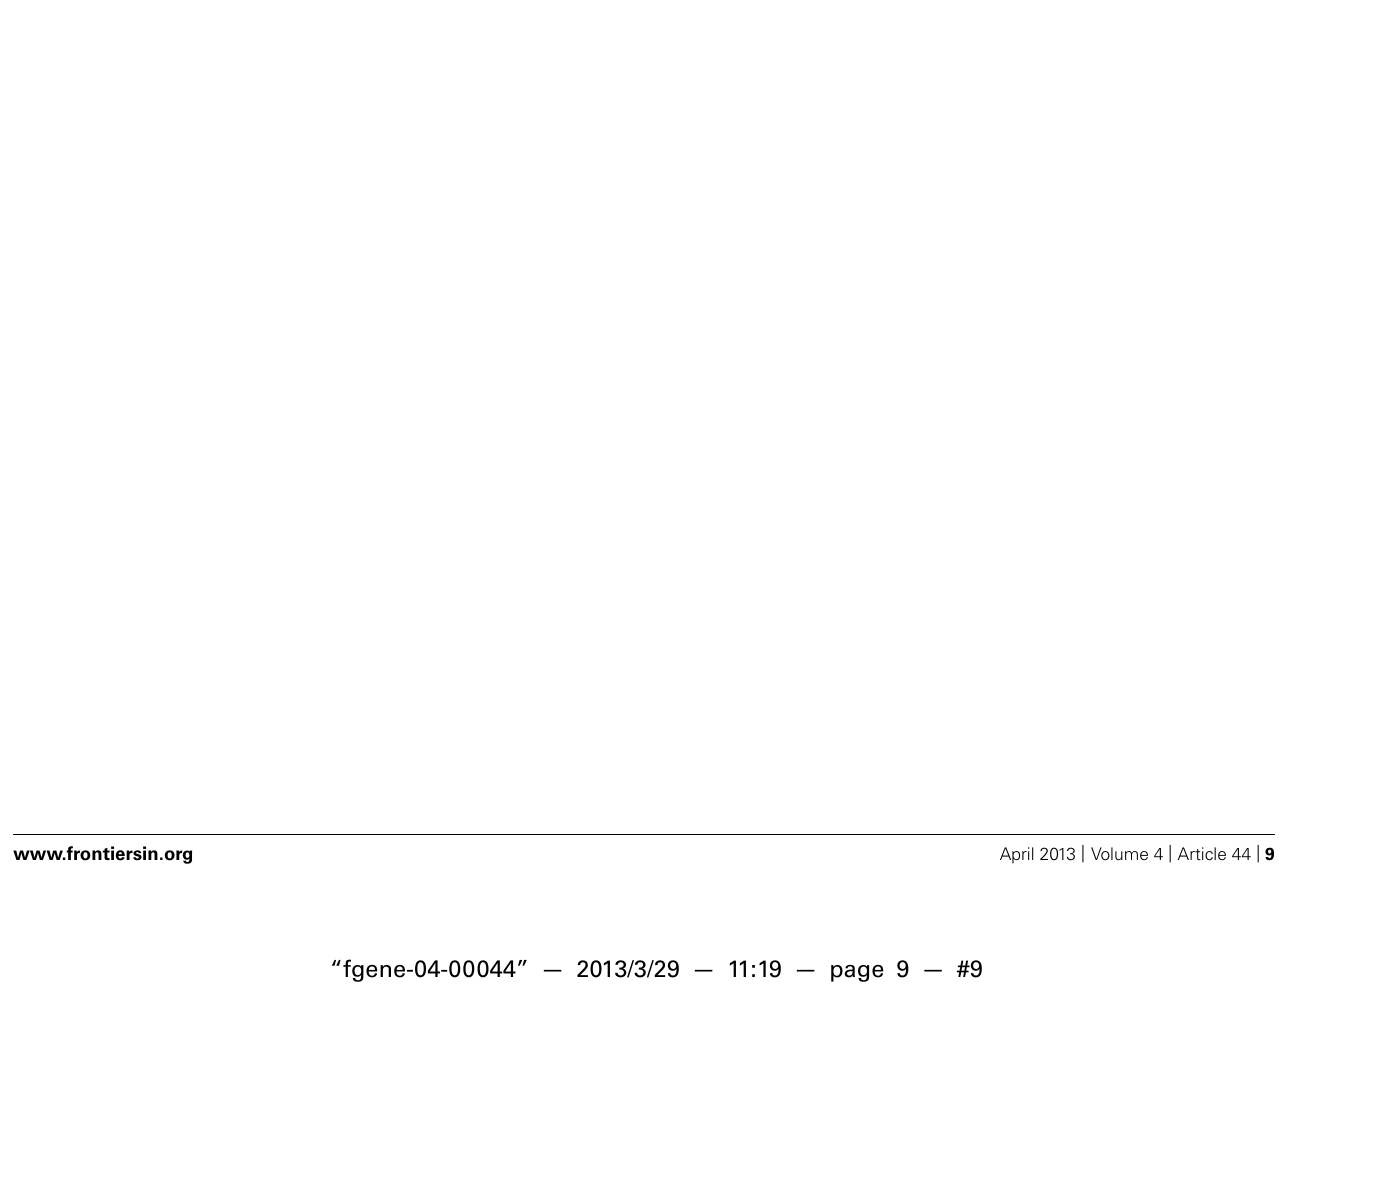
FIGUREA1 | Graphical representation of cytosine methylation status of CaMV 35S promoter. Sequencing data for PCR products amplified from bisulfite-treated DNA from plants infected with A1:35Spro (upper) and both A1:35Spro and A1:NbROS1 (lower) have been compiled. For these plants, 14 and 15 clones were sequenced, respectively. Open boxes indicate unmethylated cytosines. Red, green, and blue boxes